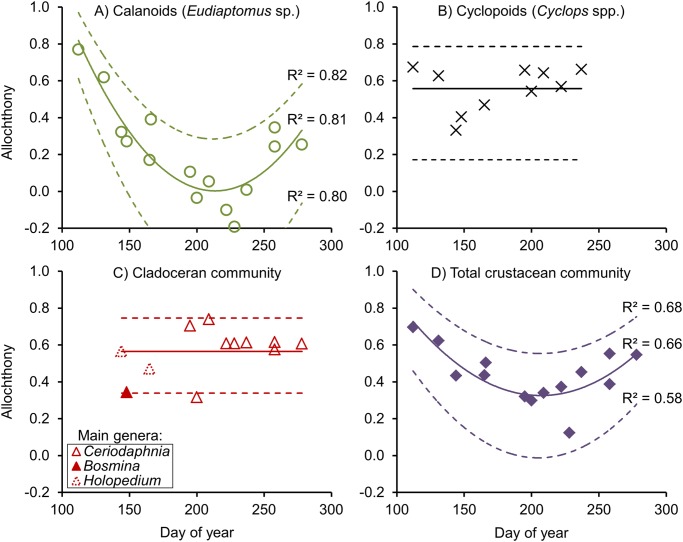
Allochthony of (A) calanoid copepods, (B) cyclopoid copepods, (C) total cladocerans, and (D) the biomass-weighted mean of the total crustacean zooplankton community, as functions of the ordinal date of lake Övre Björntjärnen 2009 and 2011.Curved solid regression lines show significant quadratic relationships (p < 0.01). Dashed lines show the corresponding relationships in high and low end allochthony scenarios, obtained by manipulating model parameters in all possible combinations as explained in the text. In lack of significant relationships, straight lines indicate means.